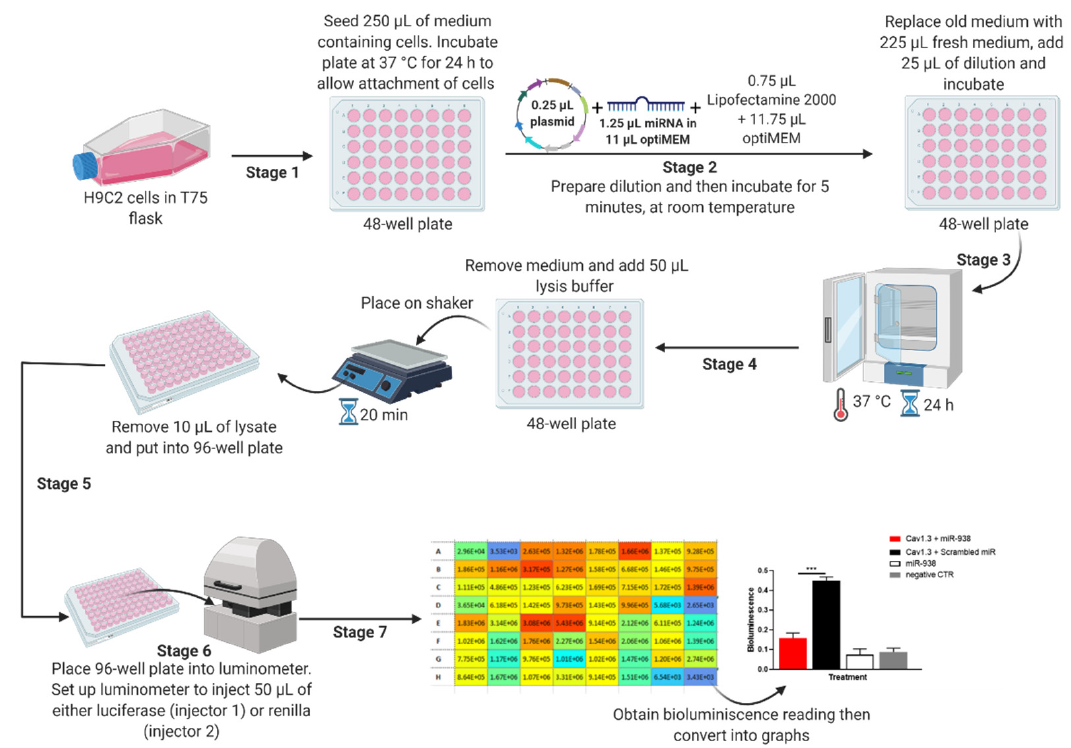
Figure 1. Summary of main methods. H9C2, a rat cardiomyoblast cell line; OptiMEM (Life Technologies, Inc., Gaithersburg, MD, USA), minimal essential medium; and miRNA, microribonucleic acid. Created with BioRender.com.